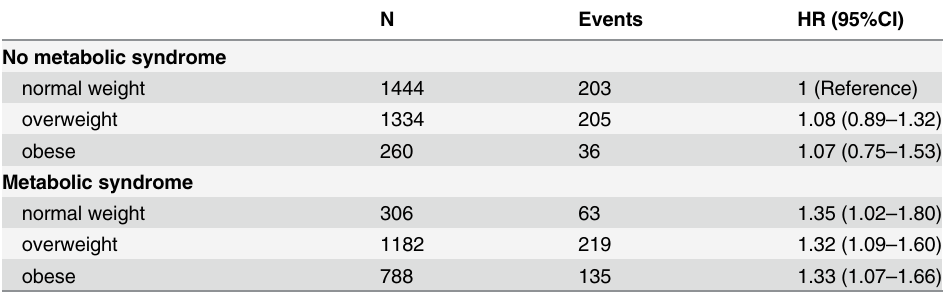
Table 2. Association of the joint body mass index and metabolic syndrome phenotypes with cardio- vascular disease.